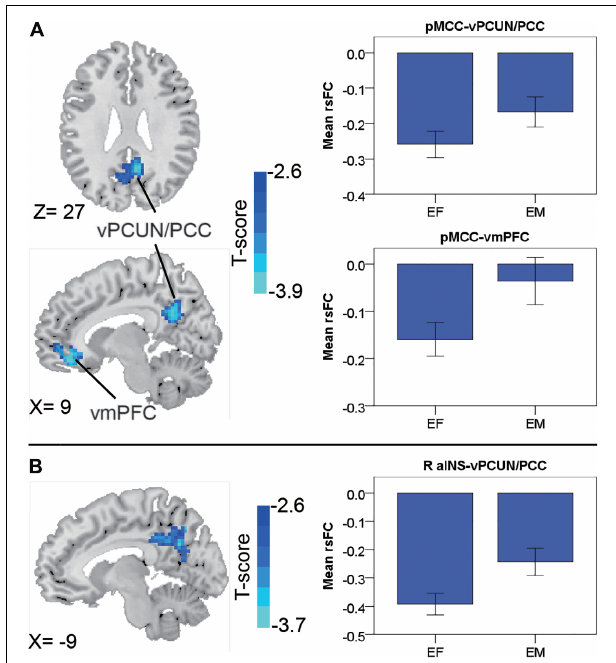
FIGURE 3 | Regions showing the gender differences in the early-adulthood stage detected by two-sample t -test (with a permutation test correction threshold of p < 0.05) in the pMCC(–) network (A) and the right aINS(–) network (B) , each with the corresponding mean strength between the seed and region for the males and females shown in the bar plot, error bars indicated two standard errors (pMCC, posterior midcingulate cortex; aINS, anterior insula; vPCUN, ventral precuneus; PCC, posterior cingulate cortex; vmPFC, ventromedial prefrontal cortex; R,